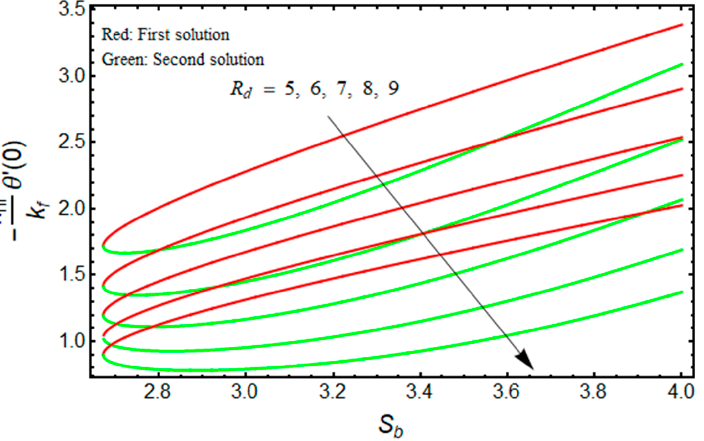
Figure 11. Effect of φ on −